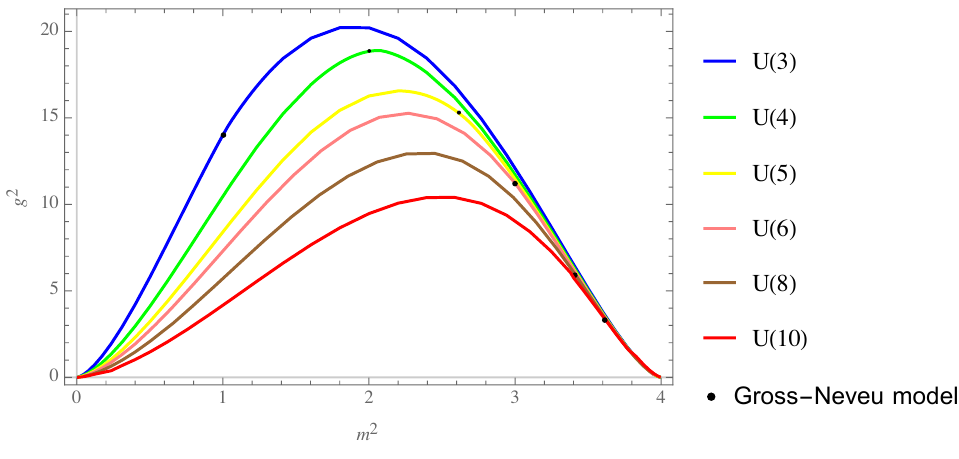
Figure 6 . Comparison of the numerical S -matrix with the O(8) S -matrix. We have subtracted the pole structure of each S -matrix individually for clarity.